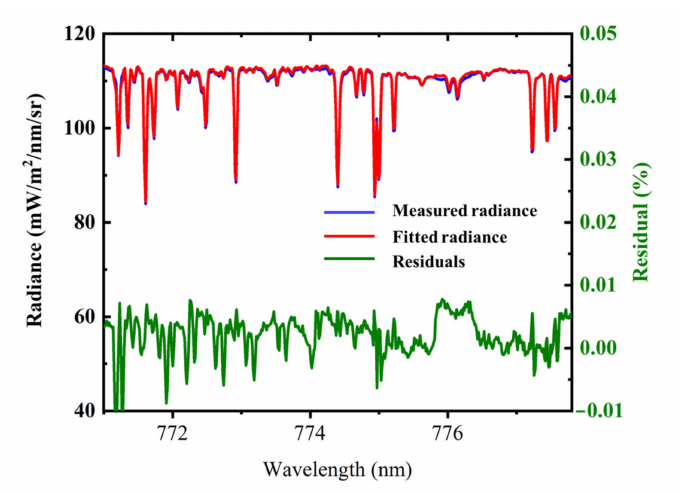
Figure 2. Exemplary spectral fit and its residuals in the spectral window of 771–778 nm. The left axis shows radiance, and the right axis corresponds to the